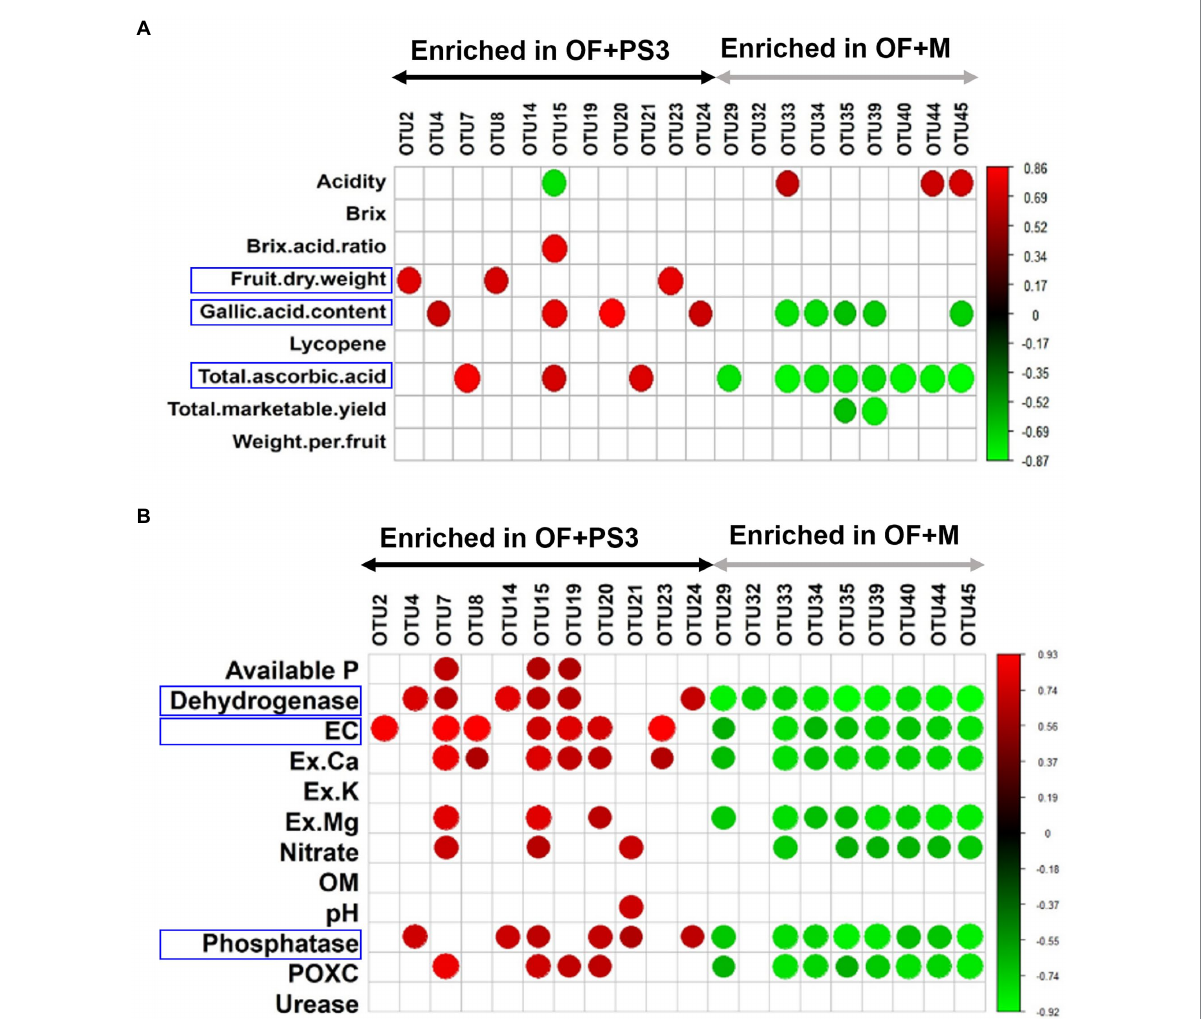
FIGURE 7 Pearson correlation between the relative abundance of individual microbial groups and plant/soil characteristics. (A) Selected OTUs versus tomato harvesting characteristics. (B) Selected OTUs versus soil properties. The red and green nodes represent the positive and negative Pearson’s correlation coefficients ( r ), considering a p value <0.05, respectively. Each treatment consisted of five biological